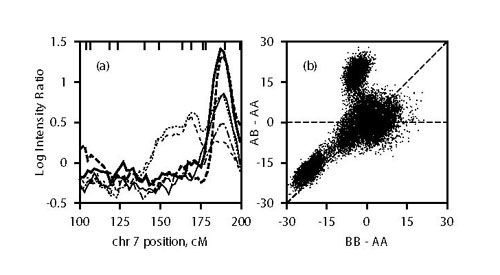
Results from Loki Chromosome 7 results from Loki. (a) Log10 IR for HDL (heavy dashed); HDLA (heavy solid); HDLAA (light solid); log(TG/HDL) with covariates CV1 and CV2 (dotted); HDLA with covariates CV2 and lnTG (dash-dot); and lnTG with CV1 and CV2 (double dashed). (b) Difference in genotype values for the heterozygote vs. AA homozygote (AB-AA) and BB homozygote vs. AA homozygote (BB-AA) for all iterations with QTL located between 175 and 195 cM, for a run based on HDLA (Table 1). Dashed lines indicate positions of dominant models. Positions of markers 11–22 are indicated along the top.